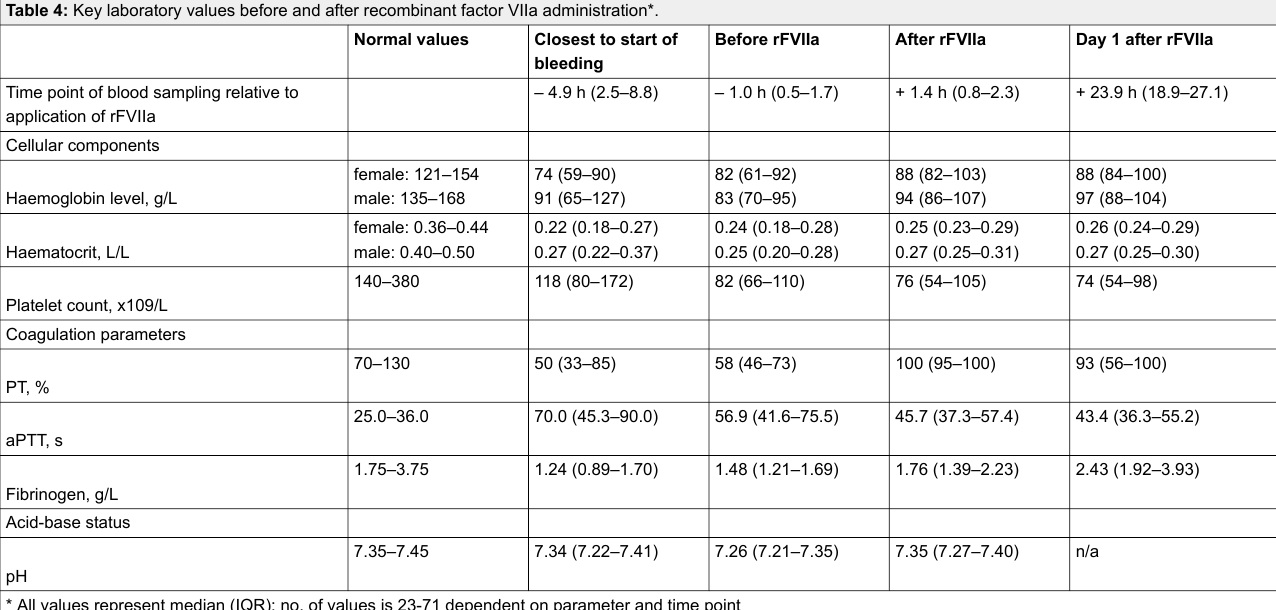
Table 4: Key laboratory values before and after recombinant factor VIIa administration*.